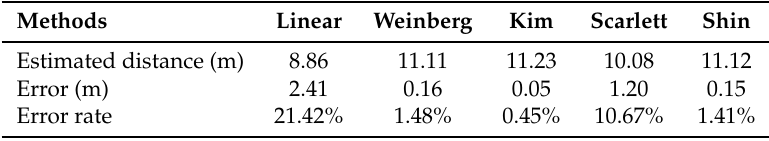
Table 1. Comparison of step length estimation algorithms (Real distance: 11.28